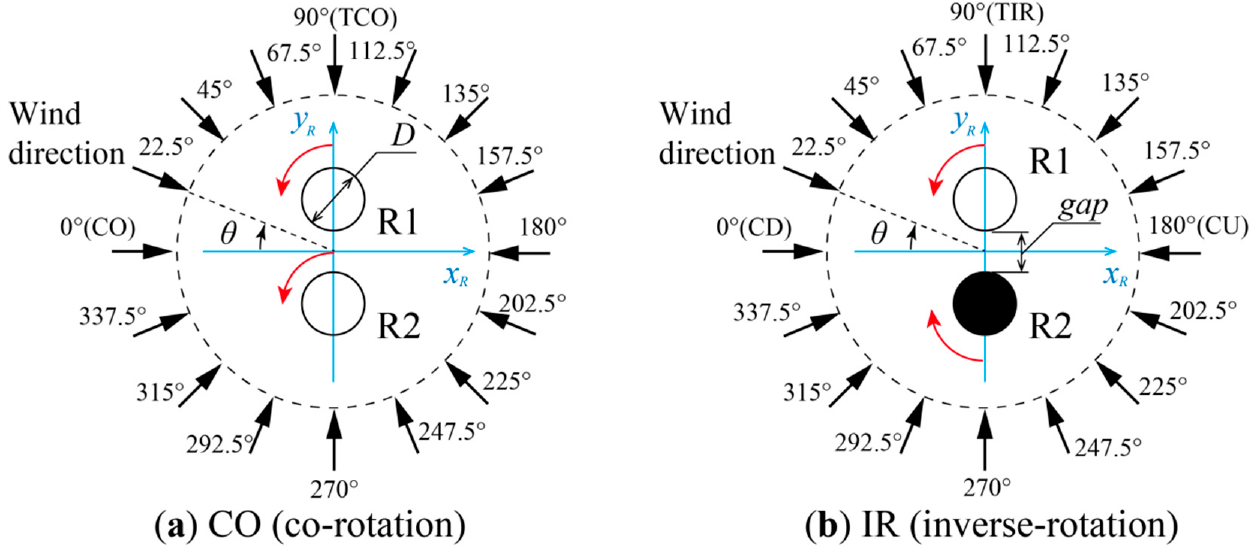
Figure 4. Definition of 16-wind-direction configurations: ( a ) co-rotation (CO) configurations; ( b ) inverse-rotation (IR) configurations.